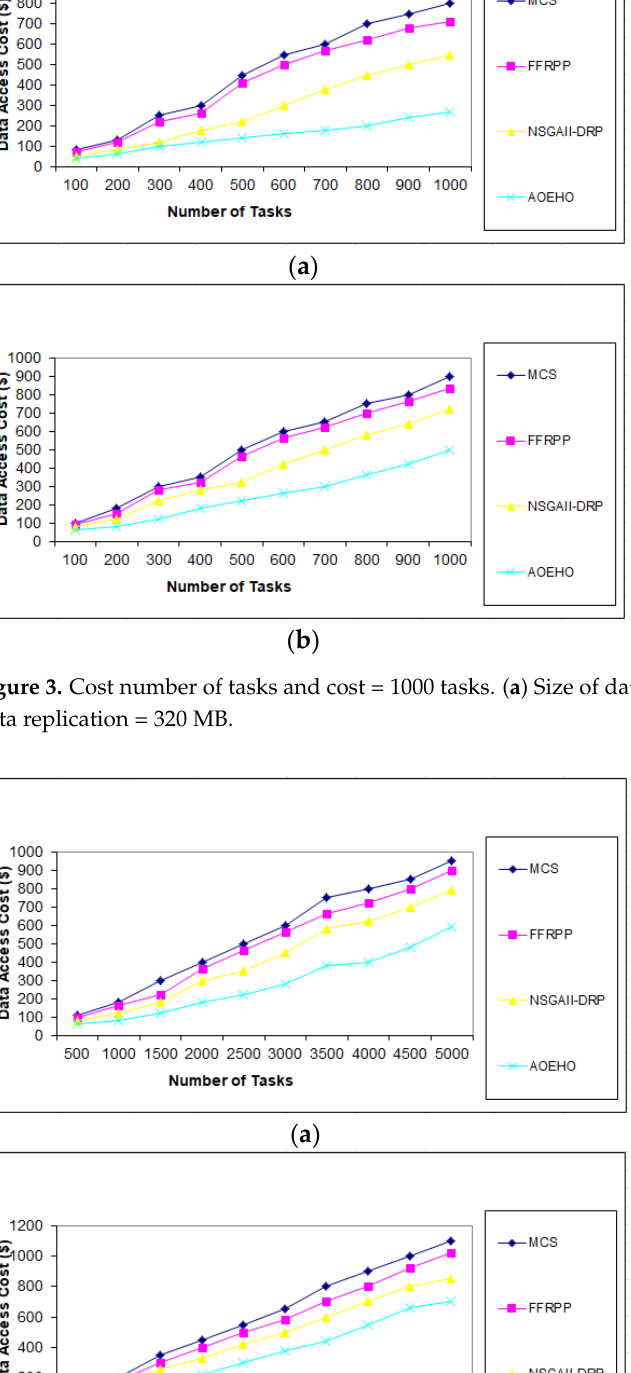
Figure 2. Cost number of tasks and cost = 100 tasks. ( a ) Size of data replication = 64 MB. ( b ) Size of data replication = 320 MB.